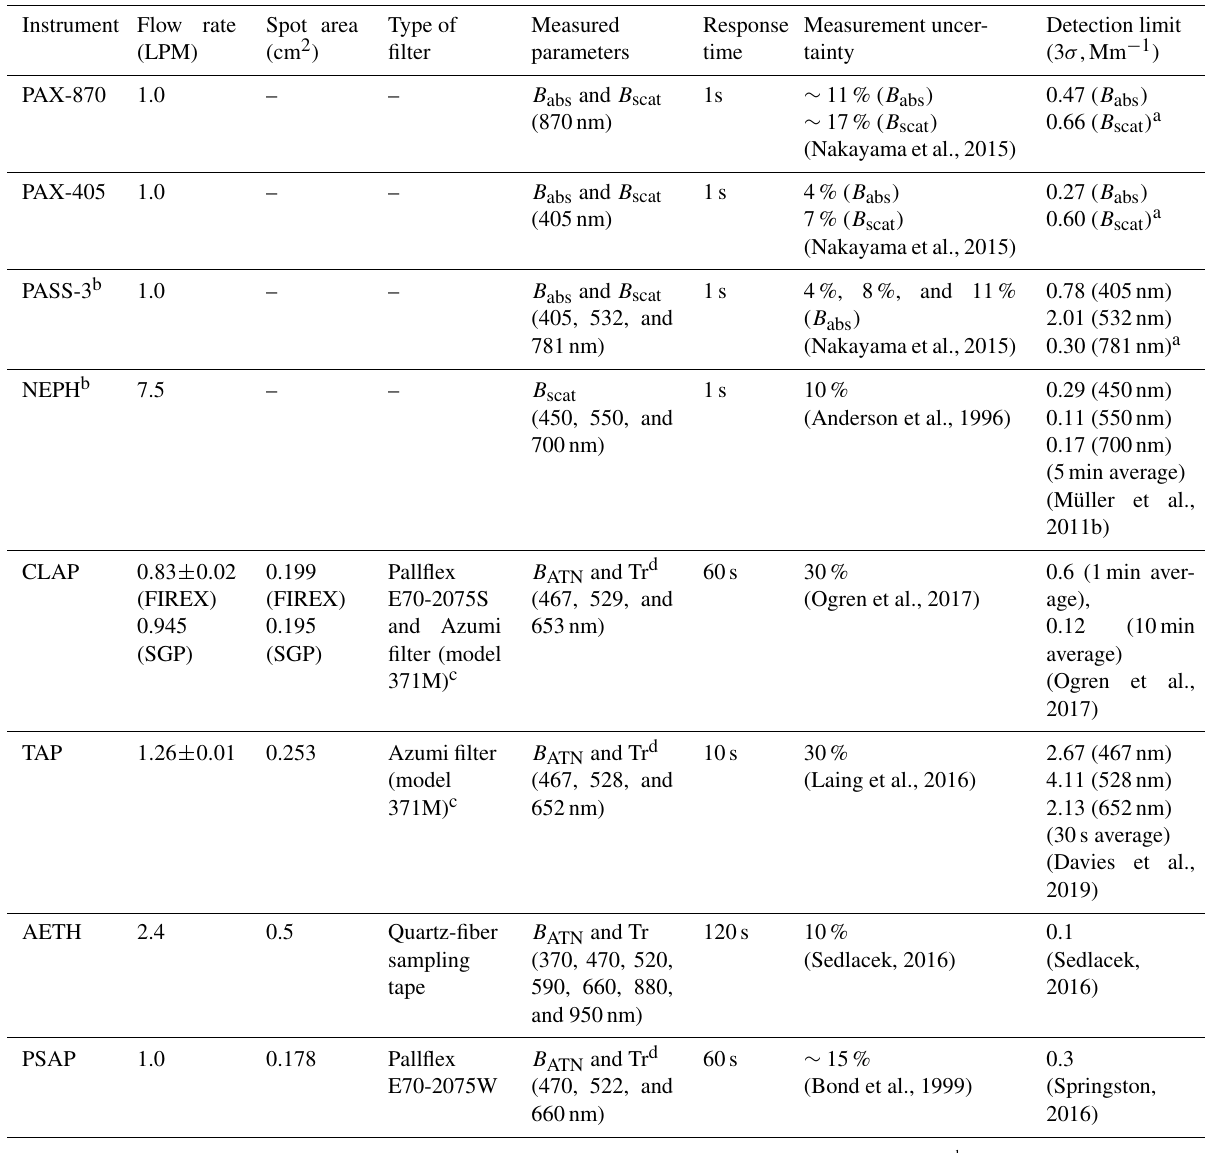
Table 1. Summary of specifications for instruments relevant to this